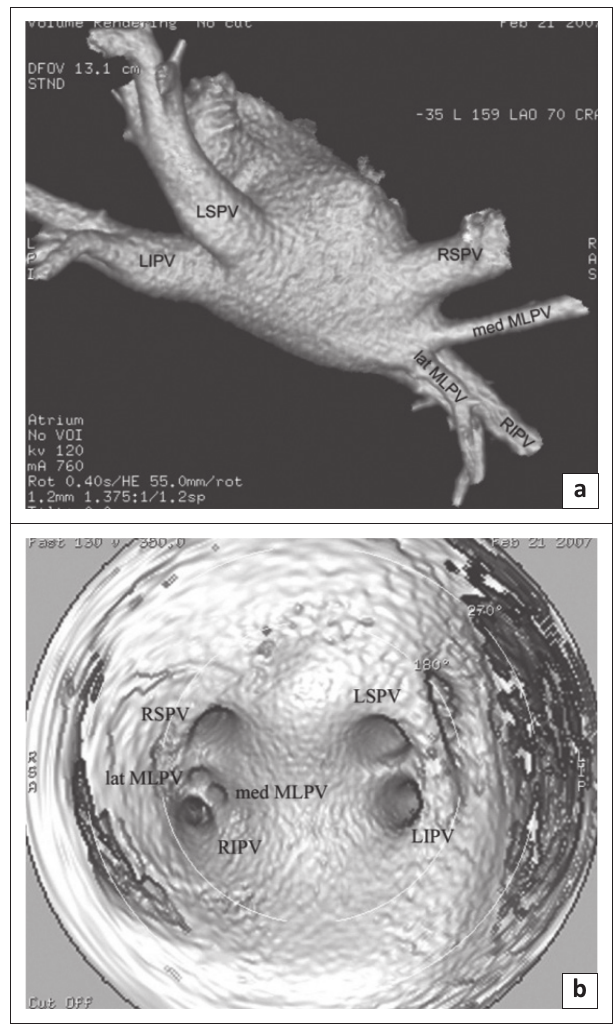
LSPV, left superior pulmonary vein; LIPV, left inferior pulmonary vein ostium; RSPV, right superior pulmonary vein ostium; med MLPV, middle lobe pulmonary vein ostium draining the medial segment of the middle lobe; lat MLPV, middle lobe pulmonary vein ostium draining the lateral segment of the middle lobe; RIPV, right inferior pulmonary vein. FIGURE 6: Multiples of supernumerary veins in another patient with atrial fibrillation, with two middle lobe veins (one draining the medial segment and the other draining the lateral segment of the middle lobe) draining directly into the left atrium. Left superior pulmonary vein (LSPV), left inferior pulmonary vein ostium (LIPV), right superior pulmonary vein ostium (RSPV), middle lobe pulmonary vein ostium draining the medial segment of the middle lobe (med MLPV), middle lobe pulmonary vein ostium draining the lateral segment of the middle lobe (lat MLPV) and right inferior pulmonary vein (RIPV): (a) Three- dimensional model. (b) Endocardial